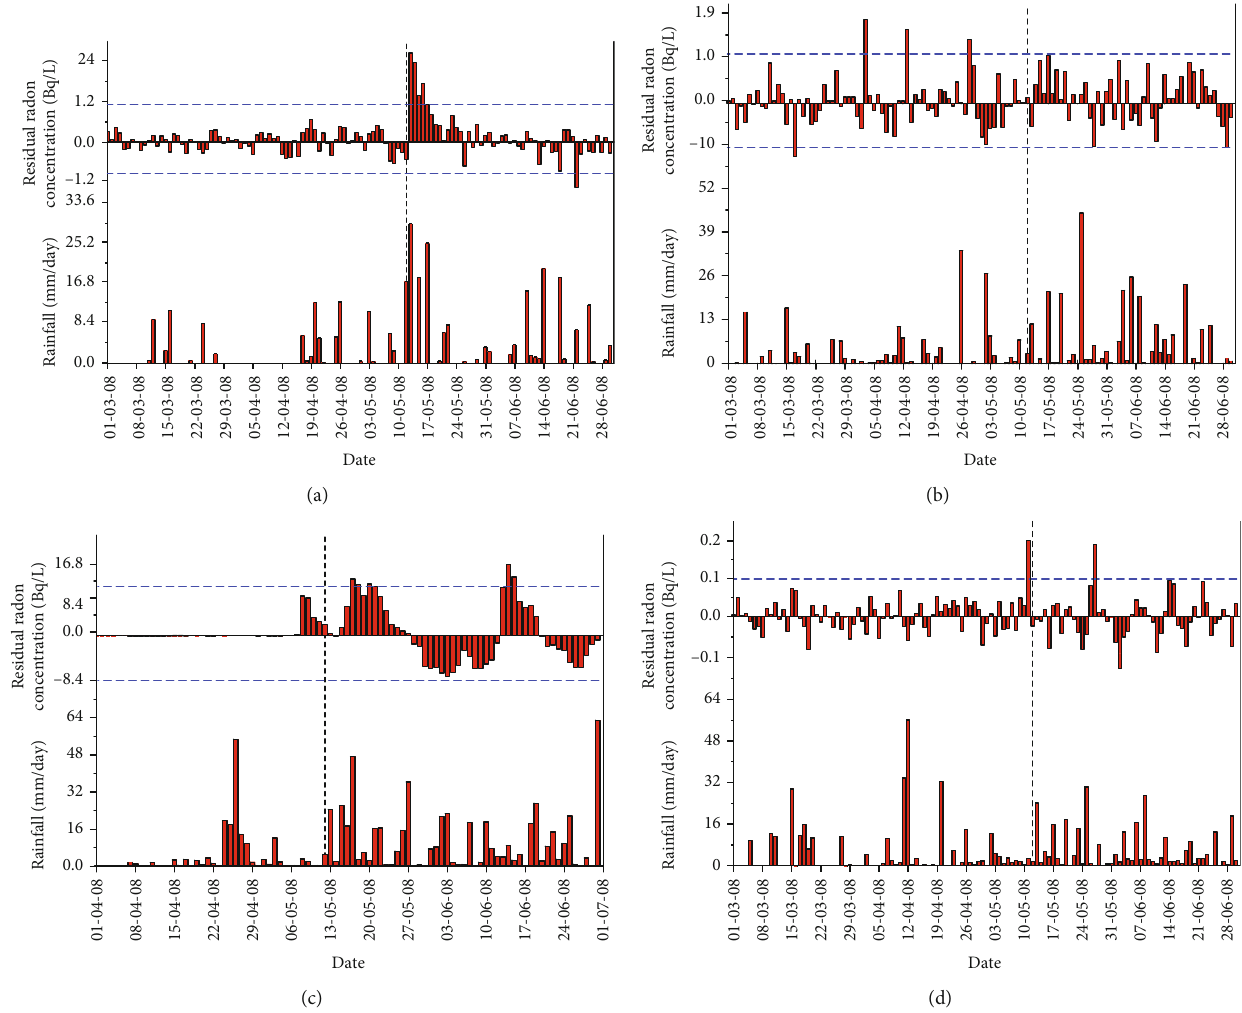
Figure 5: The results of the residual Rn time series for (a) MSS, (b) MXS, (c) KDS, and (d) SPS monitoring stations along with daily precipitation record. The MSS station shows a very notable change in the residual Rn overpassing the statistical criterion immediately following the Wenchuan earthquake (indicated by the dotted black colour vertical line) as co- and post earthquake Rn anomalies, while the rest of the stations exhibit both pre- and post earthquake signature with an insigni fi cant